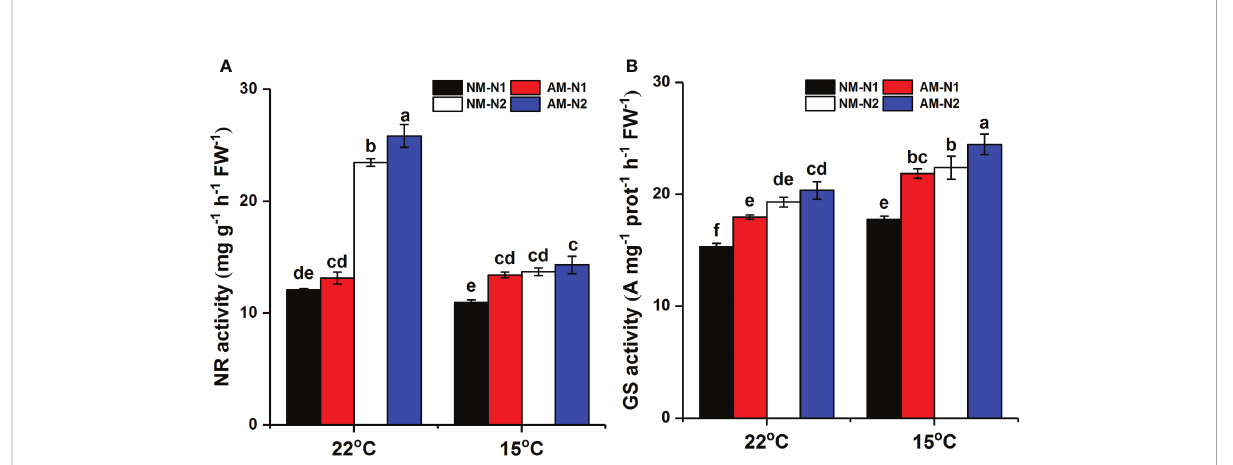
FIGURE 6 NR (A) and GS (B) activity of non-mycorrhizal and mycorrhizal rice treated with different temperatures and N levels. Abbreviations are de fi ned in Figure 4. Values are the means ± standard errors of three biological replicates. Different letters in the column represent signi fi cant differences (P<0.05) based on Duncan ’ s